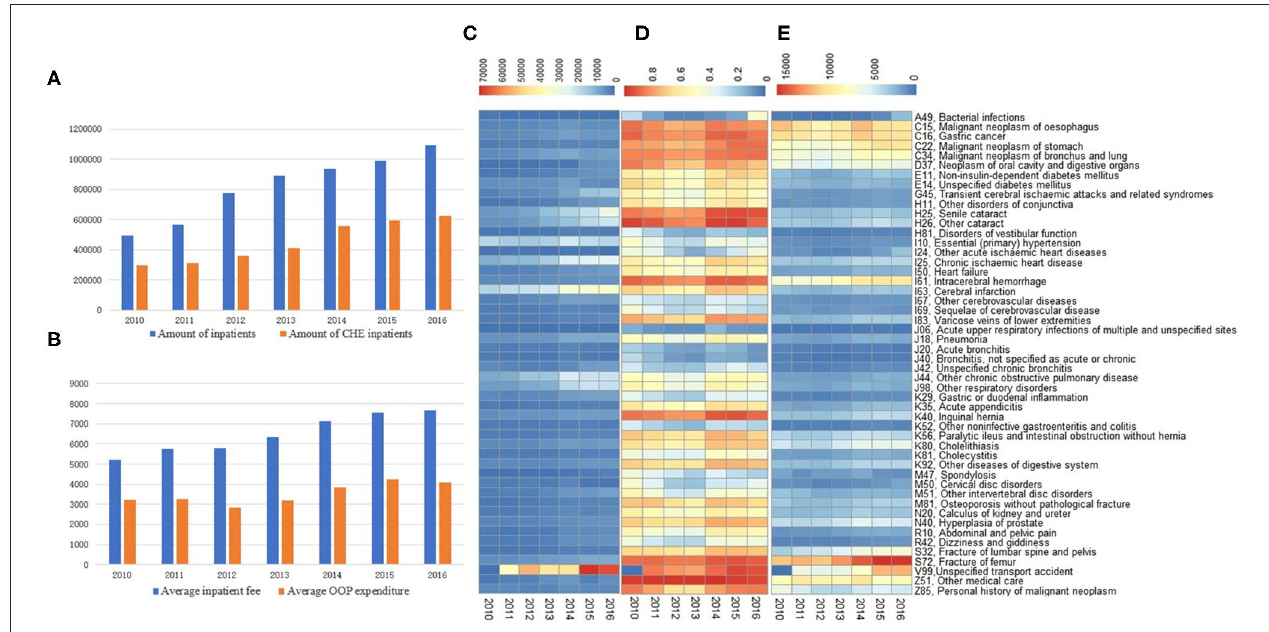
FIGURE 1 | Medical expenditures and prevalence of catastrophic health expenses (CHE) of rural elderly inpatients, from 2010 to 2016. (A) Amounts of inpatients and inpatients with CHE. (B) Average inpatient fee and out-of-pocket (OOP) expenditure of inpatients, unit Yuan. (C) Amounts of inpatients with CHE in the top 50 discharge diagnoses. (D) The prevalence of CHE in the top 50 discharge diagnoses. (E) Average OOP expenditure in the top 50 discharge diagnoses, unit Yuan.